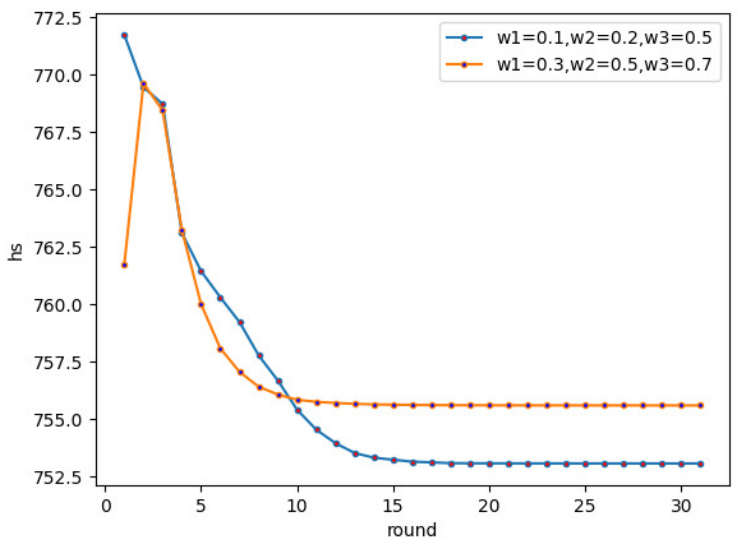
Figure 12. Effect of w 3 : h s changes with time.